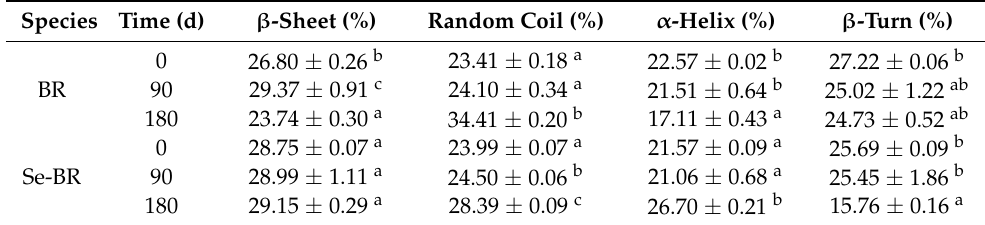
Table 1. Secondary structure composition of BR and Se-BR.